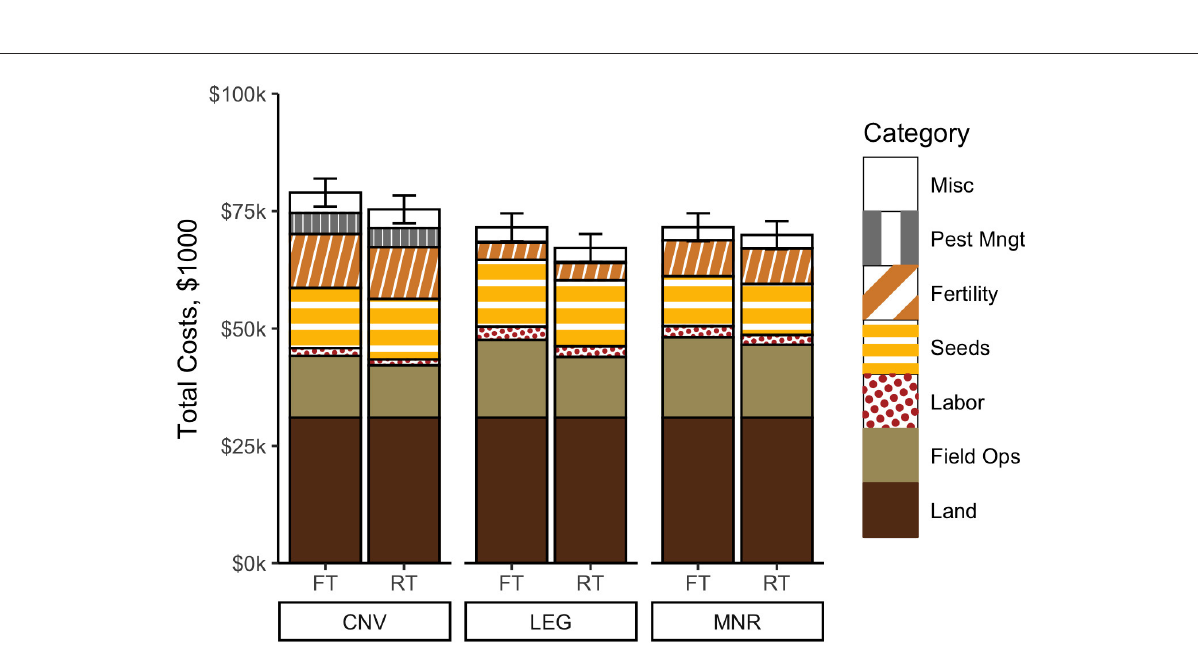
FIGURE2 Average annual costs for each representative farm with different tillage × system treatments. Total costs include land (brown), field operations (variable and fixed preharvest and harvest actives; tan), labor (dotted red), seeds (horizontal yellow lines), fertility inputs (diagonal gold lines), pest management inputs (vertical gray lines), and all other costs (interest, insurance, and miscellaneous expenses; white). Error bars are standard errors for total costs within each tillage × system